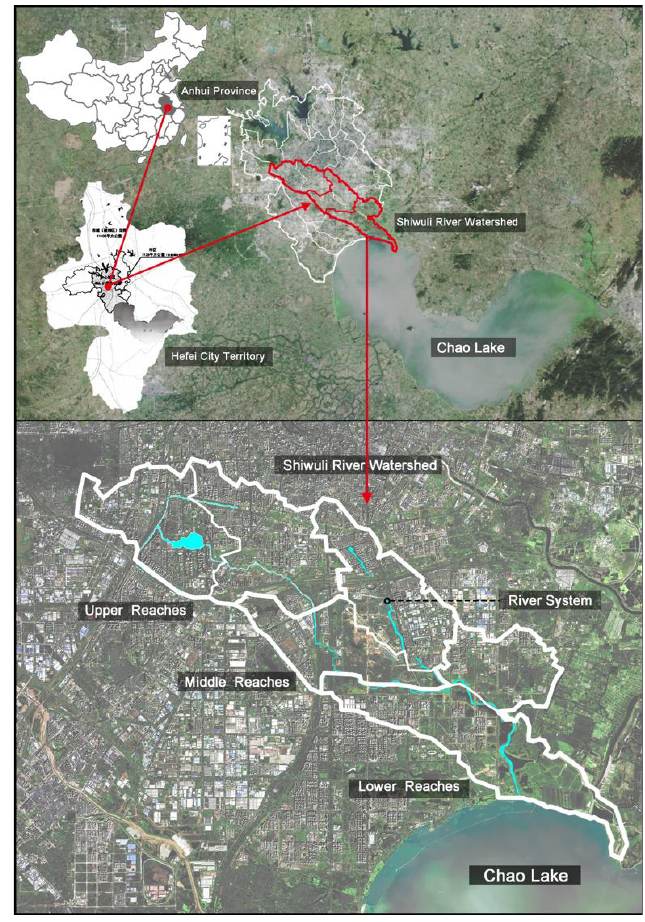
Figure 1. The study